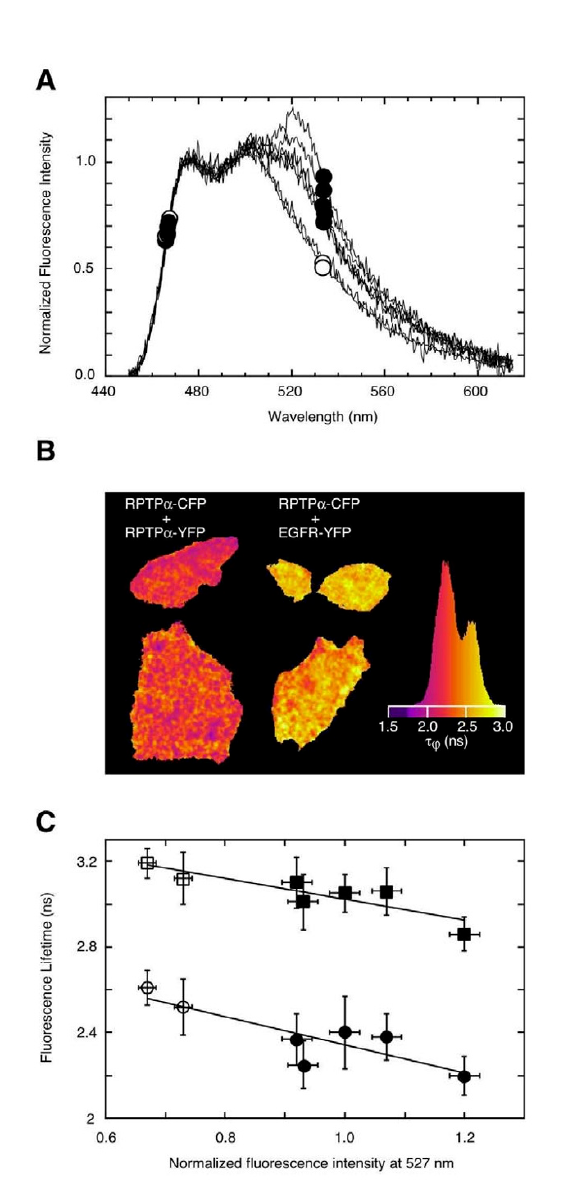
Figure 3 SPIM and FLIM confirm FRET in full length RPTP α -CFP and -YFP expressing cells. (A) Normalized uncorrected fluorescence emission spectra of plasma membrane regions of single SK-N-MC cells expressing both RPTP α -CFP and RPTP α -YFP (closed circles) or SK-N-MC cells expressing both RPTP α -CFP and EGFR-YFP (control, open circles) as obtained by fluorescence spectral imaging microscopy (SPIM). The emission spectra were normalized to the first emission peak of the CFP spectrum (at 475 nm) for comparative reasons (note that due to this normalization procedure no 'quenching' of CFP fluorescence due to FRET seems apparent from the figure). (B) CFP-fluorescence lifetime images ( τφ , calculated from the phase shift) of cells expressing both RPTP α -CFP and RPTP α -YFP (left) or RPTP α -CFP and EGFR-YFP (control, right). The histogram represents the distribution of fluorescence lifetimes throughout the image. (C) Correlation between FLIM and SPIM data of cells express- ing both RPTP α -CFP and RPTP α -YFP (closed symbols) or RPTP α -CFP and EGFR-YFP (control, open symbols). Each point rep- resents a combined SPIM and FLIM measurement of a single cell. On the horizontal axis the normalized intensity of the emission spectrum at 527 nm is indicated (which is proportional to the YFP/CFP fluorescence emission ratio). Lifetimes deter- mined from phase ( τφ ) and modulation ( τ M ) are plotted with circles and squares, respectively. Regression analysis indicated a - 85% and -88% correlation coefficient for the respective lines. Error bars represent pixel-by-pixel standard deviations in fluores- cence lifetimes or fluorescence emission